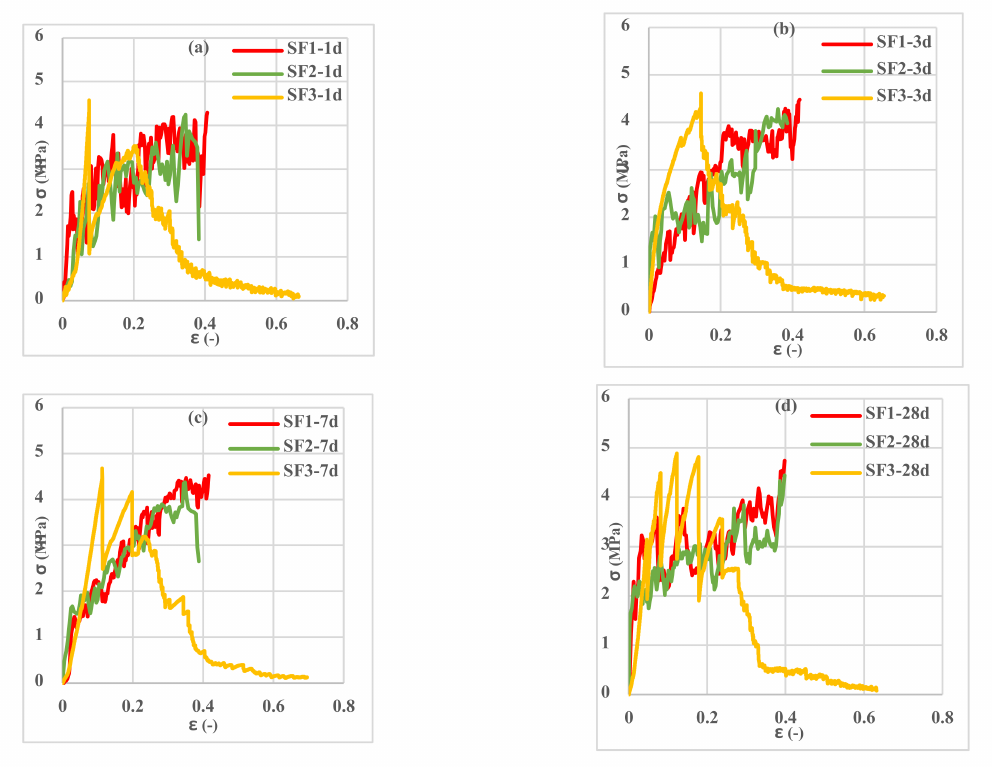
Figure 14. Tensile stress–strain curves of reinforced mortar with 3 types of spacer fabrics in the weft direction cured at 50 ◦ C temperature ( a ) 1 d, ( b ) 3 d, ( c ) 7 d, and ( d ) 28